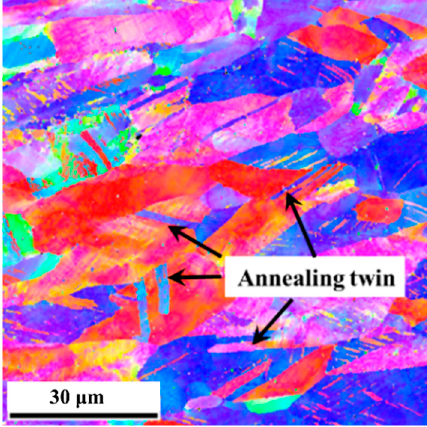
Figure 2. Microstructure of the tested alloy.